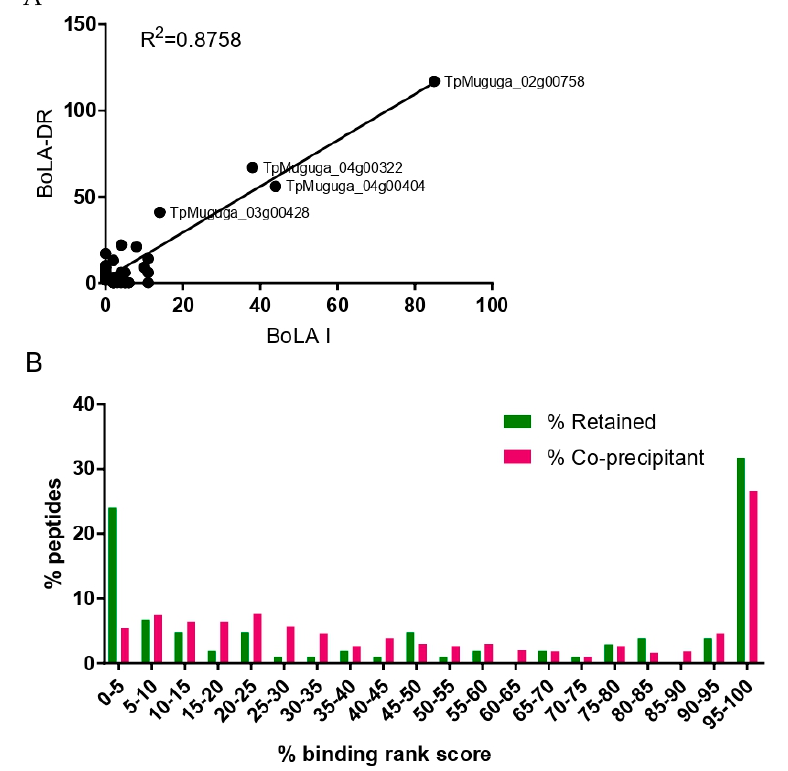
Figure 7. Coprecipitating peptides in the BoLA-MHCI and BoLA-DR datasets. ( A ) A scatterplot showing the level of correlation between the proteins from which coprecipitating peptides were derived in the BoLA-I and BoLA-DR datasets. Each point represents a single protein, and the number of coprecipitating peptides from individual proteins in the BoLA-MHCI and BoLA-DR datasets is shown on the horizontal and vertical axis, respectively. The R 2 value calculated from the Pearson’s coefficient of correlation is shown. ( B ) The distribution of percent rank prediction scores for peptides considered to be coprecipitants and peptides retained after removal of the coprecipitant peptides in the combined BoLA-DR dataset. Peptides with a percent rank prediction score of <5% are considered to be binders. A small number of short peptides (<9 amino acids long, n = 26) that did not receive a percent rank prediction score were ascribed a default value of 100%.